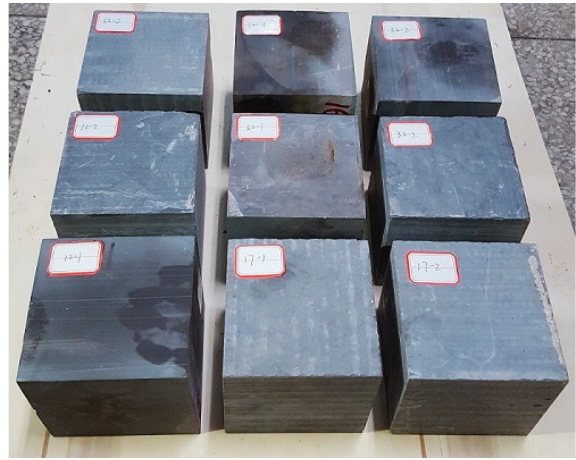
Figure 3: Cube specimens of slate for shear tests.